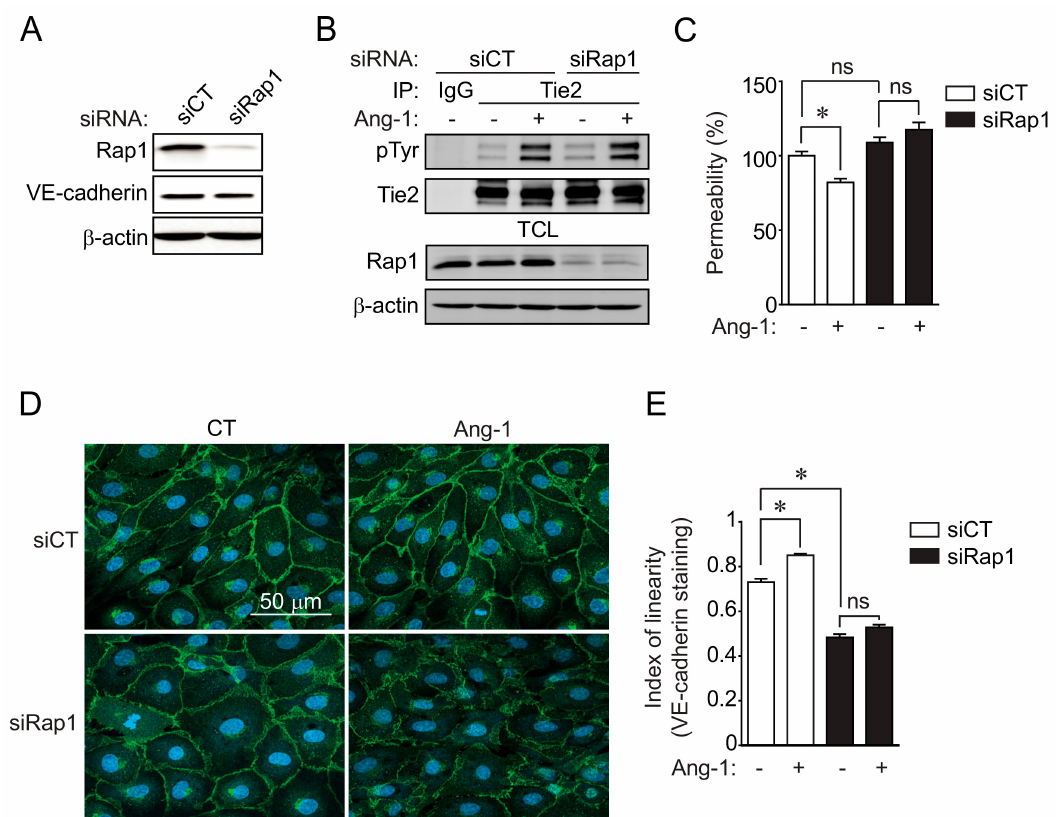
Figure 2. Rap1 is essential for Ang-1-induced cell-junction stabilization and endothelial-permeability inhibition. ( A ) siRNA-mediated downregulation of Rap1 in BAECs. BAECs were transfected with control siRNA (siCT) or targeting Rap1 (siRap1), and downregulation was confirmed by immunoblotting against Rap1. VE-cadherin and β -actin were used as loading controls. ( B ) BAECs transfected with siCT or siRap1 were stimulated with Ang-1 (100 ng / mL) for 30 min. Tie2 tyrosine phosphorylation levels were monitored in Tie2 immunoprecipitates (IP). Equal immunoprecipitation levels from BAEC lysates and Rap1 downregulation were confirmed by Western blot. This experiment was repeated three times with identical results. ( C ) Transendothelial permeability was determined by measuring the passage of fluorescein isothiocyanate (FITC)-dextran through BAEC monolayer. Passage of FITC-dextran was measured after exposure of BAECs, transfected with siCT or siRap1, to Ang-1 (100 ng / mL; 30 min). Graph presents average of three independent experiments (mean +/ – SEM; p < 0.05). ( D ) Representative confocal micrographs of BAECs stained for VE-cadherin (green) and with DAPI (nucleus, blue), and transfected with siCT or siRap1. Where indicated, cells were stimulated with Ang-1 (100 ng / mL) for 30 min prior to fixation. Linearity of cell–cell junction staining (VE-cadherin) was indicative of junction stability. ( E ) Quantification of “index of linearity” as described in Material and Methods. Graph represents average index of linearity +/ – SEM of at least n = 30 junctional sections between cells per conditions; * p < 0.05); ns: not